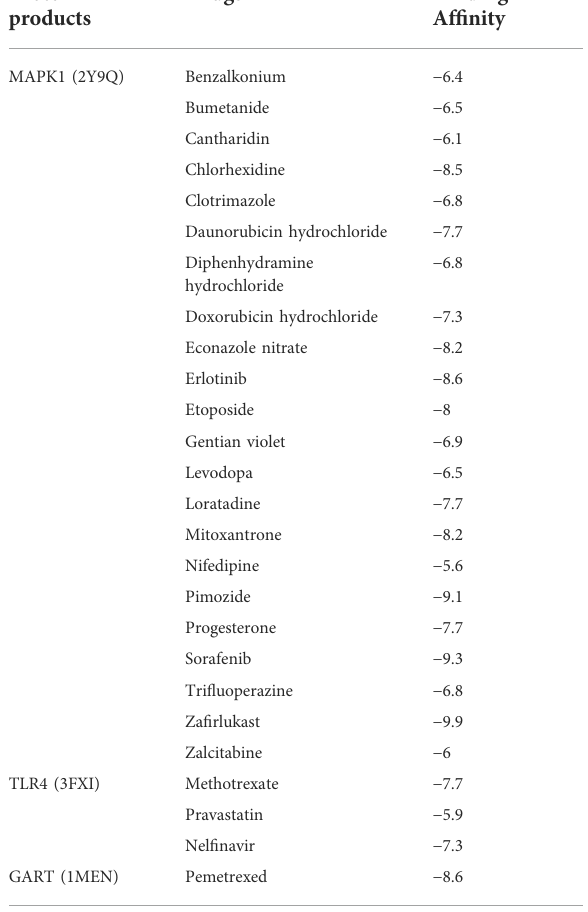
TABLE 7 The binding af fi nity of the interacting drug with the protein product of hub genes. Protein